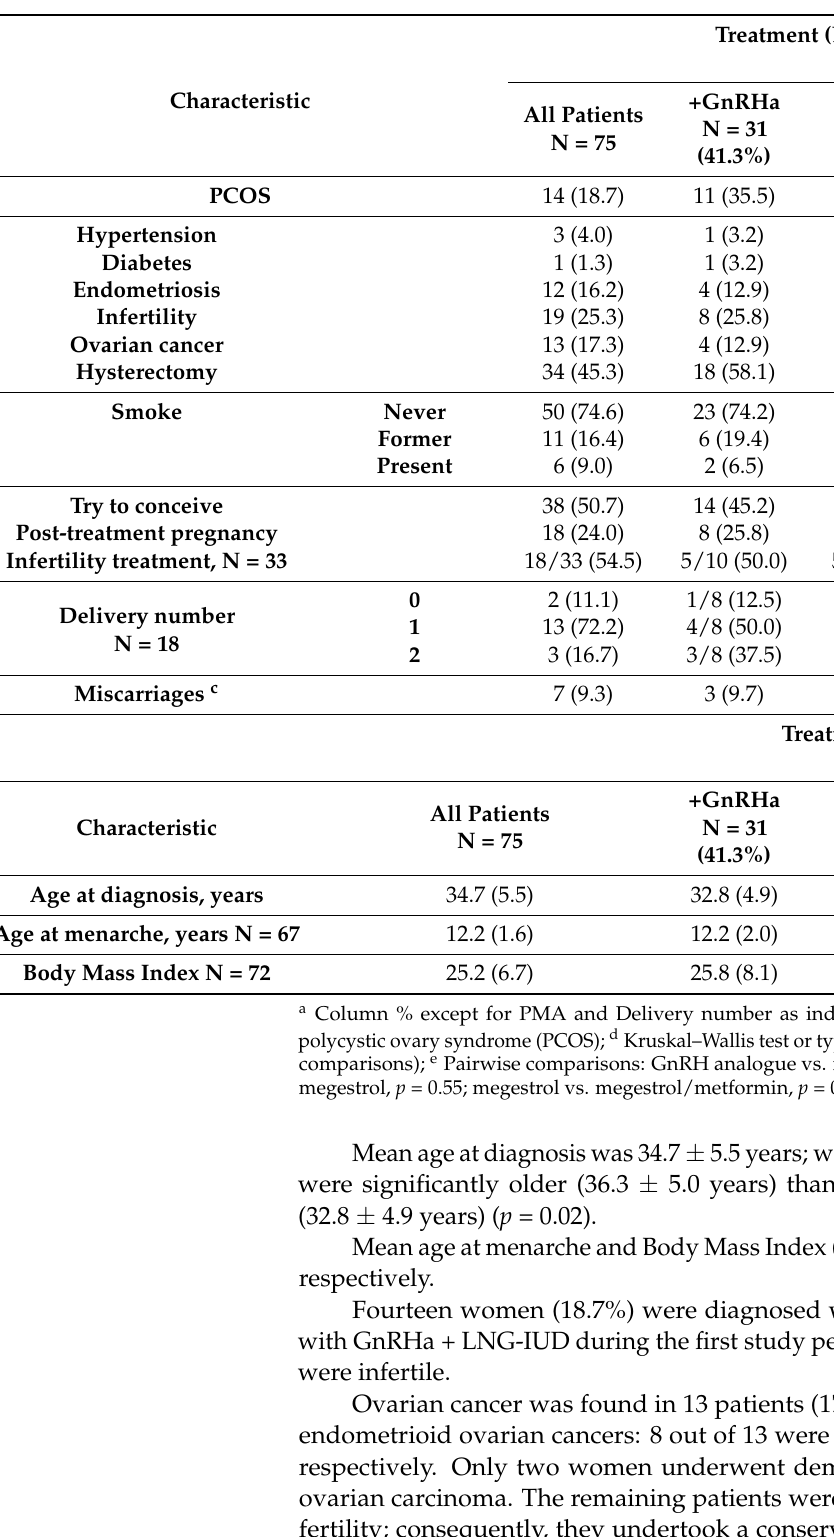
Table 1. Patient’s characteristics, categorical and continuous variables summary statistics by